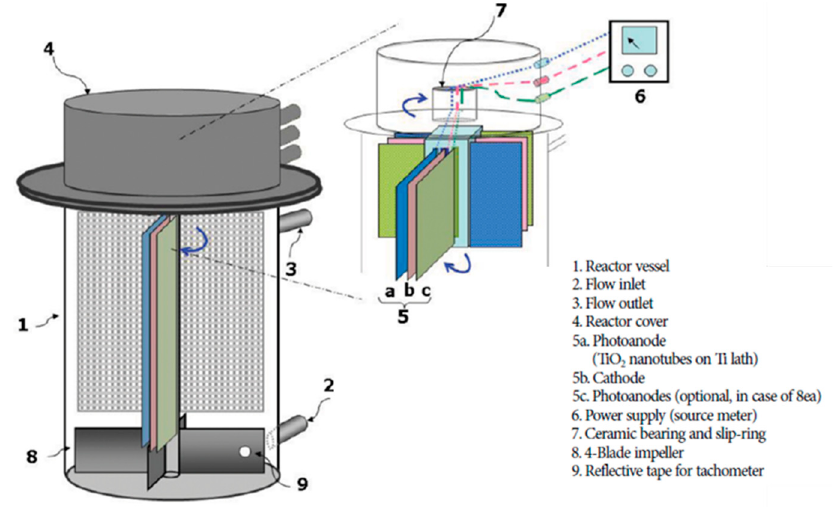
Figure 18. Rotational reactor using titanium nanotube photoanode and titanium cathode. (Adapted with permission from [78]: Cho, H.; Seo, H.S.; Joo, H.; Kim, J; Yoon, J. Performance evaluation of rotating photoelectrocatalytic reactor for enhanced degradation of methylene blue. Korean J. Chem. Eng. 2017 , 34 , 2780–2786, doi:10.1007/s11814-017-0198-7. Copyright (2017), Springer Nature (Seoul, Korea)).